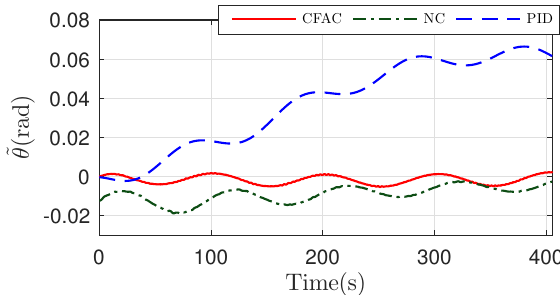
Figure 31. Pitch angle tracking error in virtual mooring.